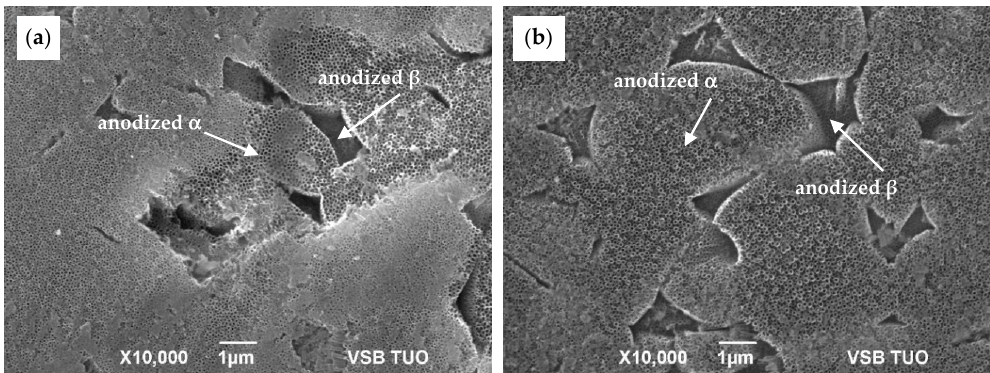
Figure 3. SEM SEI morphology of the anodized surfaces ( a ) ground and ( b ) polished.